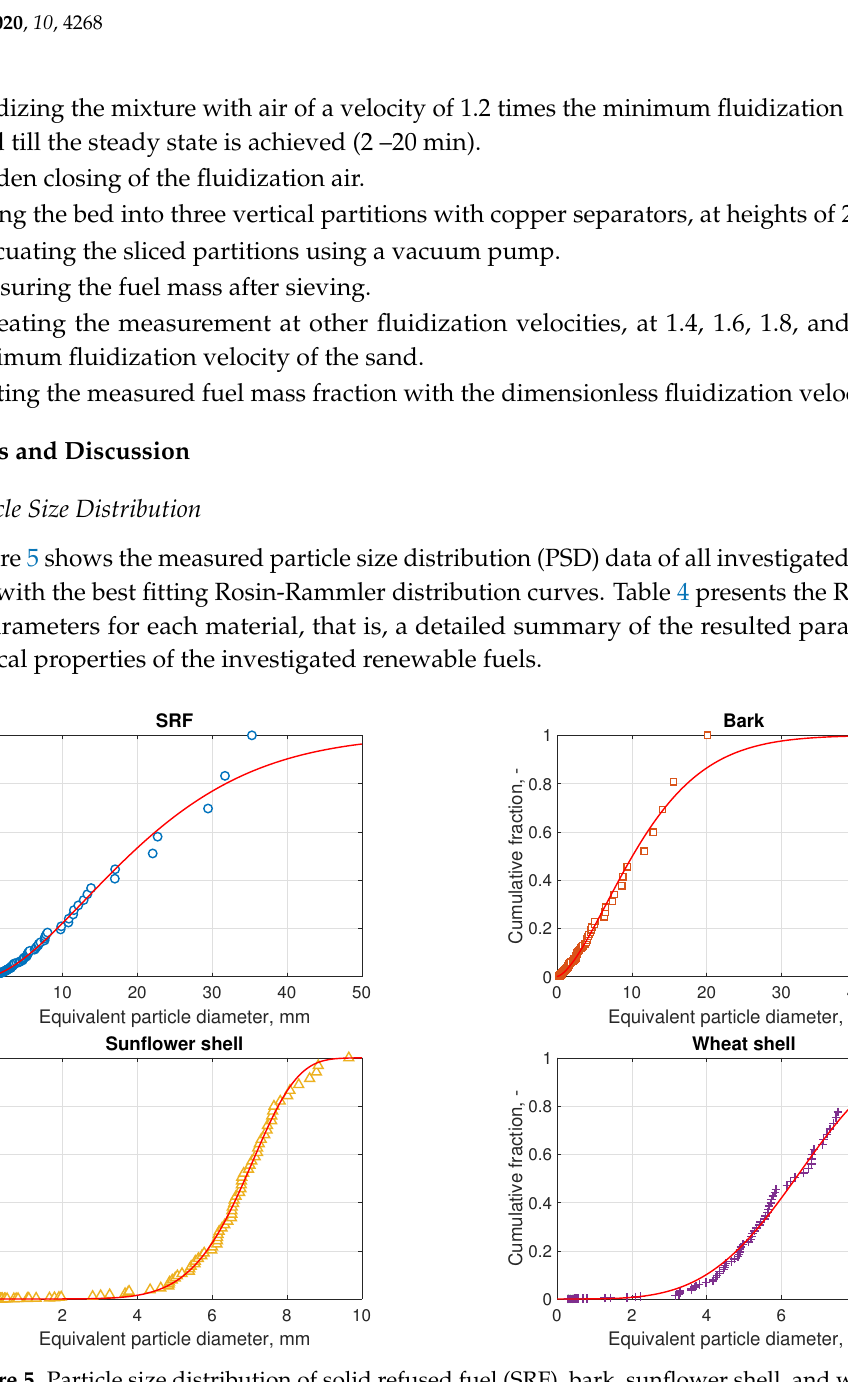
Figure 5. Particle size distribution of solid refused fuel (SRF), bark, sunflower shell, and wheat shell (markers), and the best-fitting Rosin-Rammler curves (solid lines). Table 4. Parameters of the Rosin-Rammler distribution corresponding to the best fit with the measured